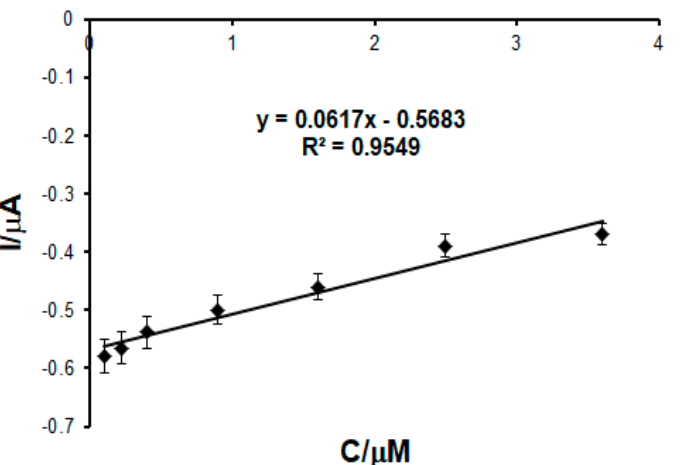
Figure 10. Linear fitting within the range 0.1–3.6 µ M for CNF-CoPc-Lac/SPE; y = I ( µ A); x = c ( µ M); R 2 -coefficient of determination.